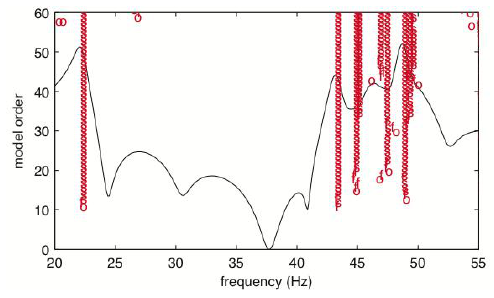
Fig. 6. Stabilisation diagram of a Transmissibility driven OMA (maximum order =